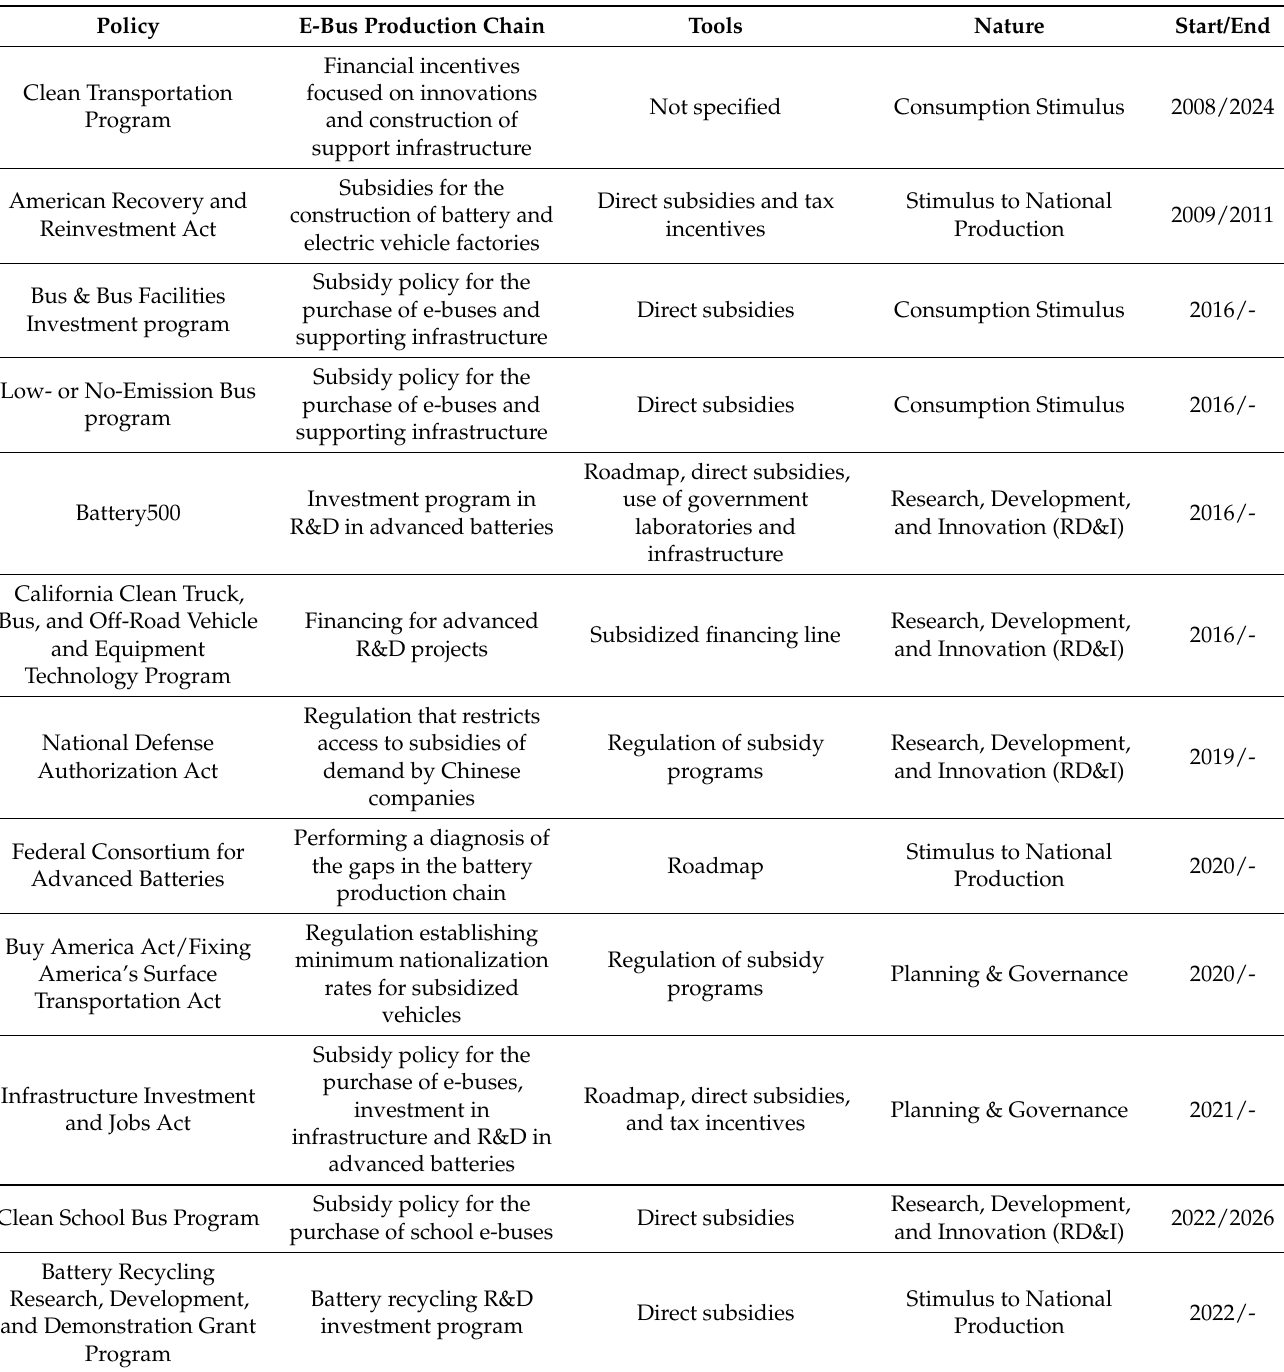
Table 1. Summary of incentive policies for the e-bus production chain in the USA